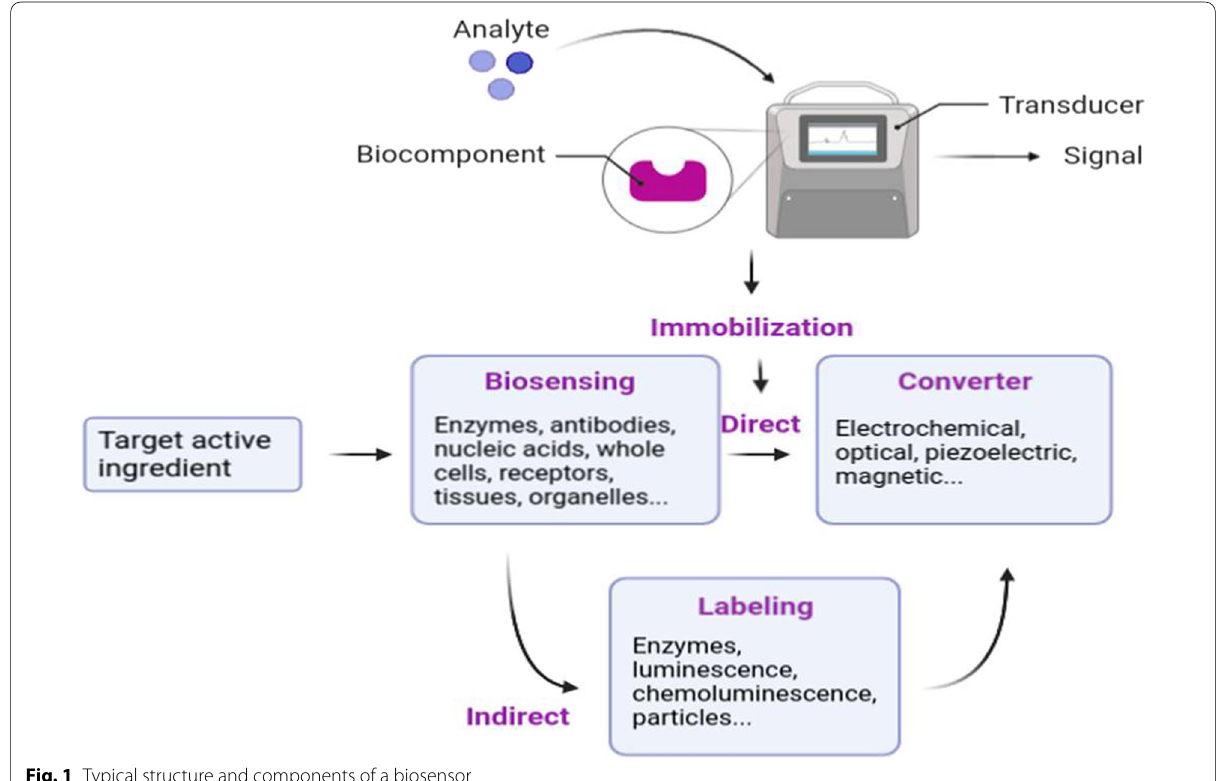
Fig. 1 Typical structure and components of a biosensor